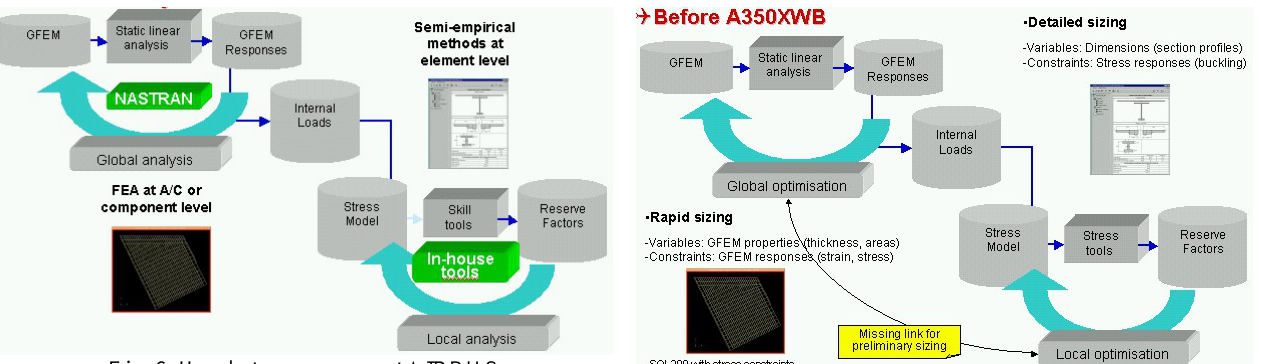
Fig. 7. Sizing optimization approaches before A350XWB